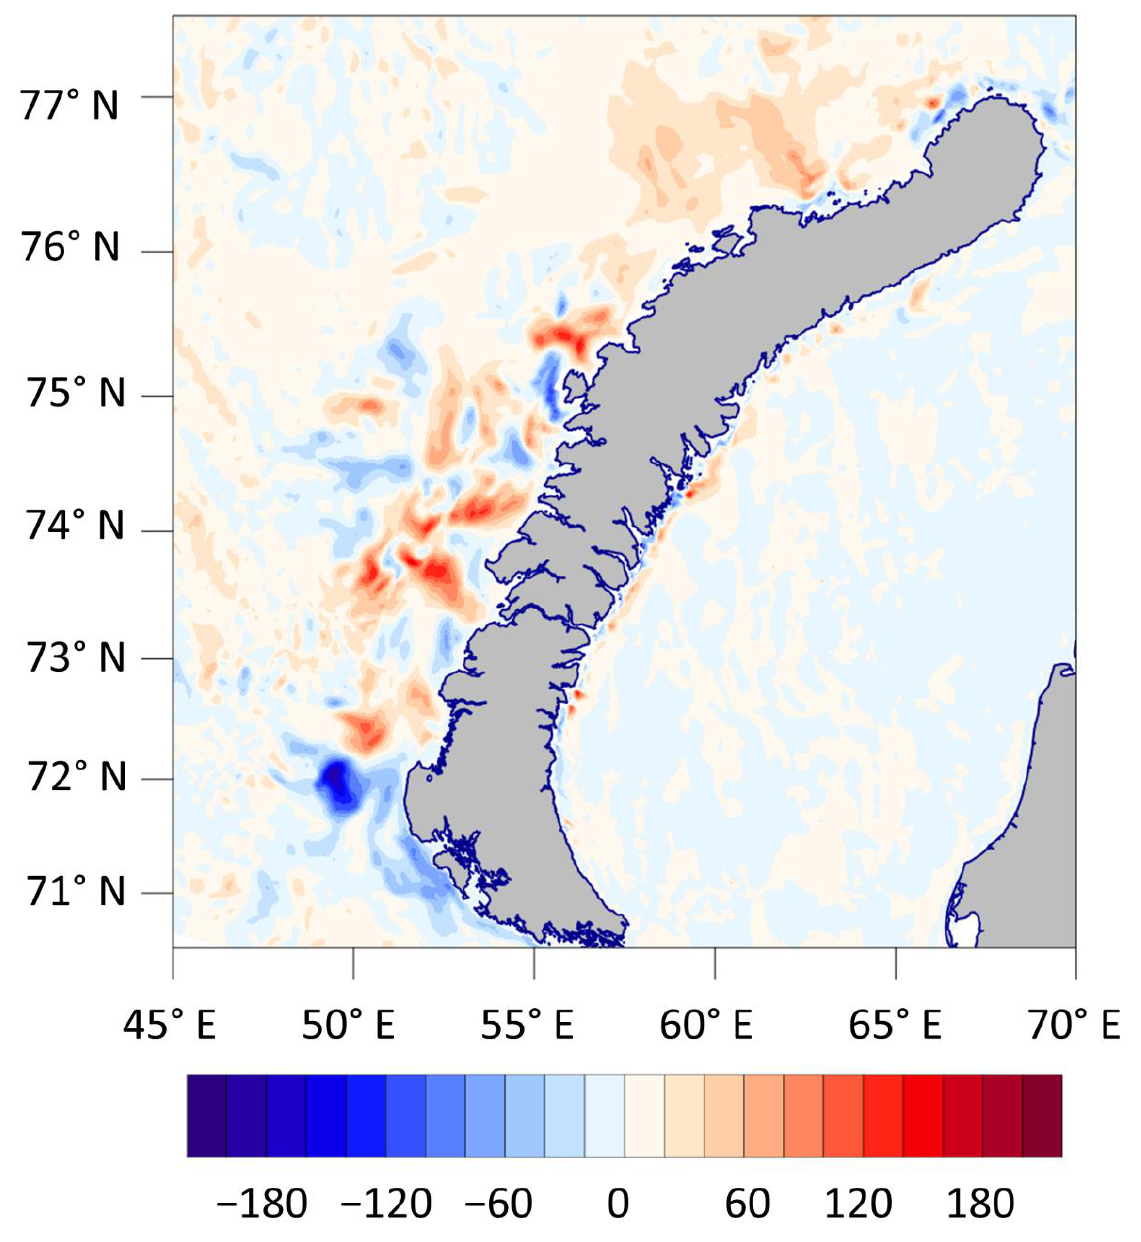
Figure 10. Difference in ocean heat content (MJ m − 2 ) between “AWO” and “AWO flat” experiment averaged over the bora period (10–12 December). Table 5. Differences in ocean heat content ∆ OHC (MJ m − 2 ) between the bora end (06UTC